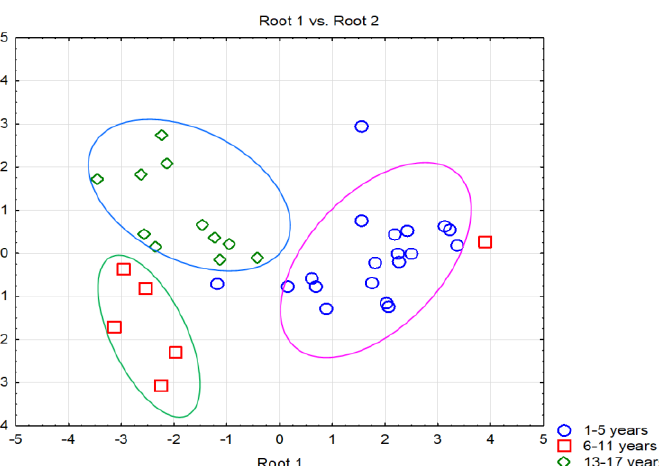
Figure 2. Graphical representation of scores corresponding to subjects with organophosphorus pesticide poisoning by age.